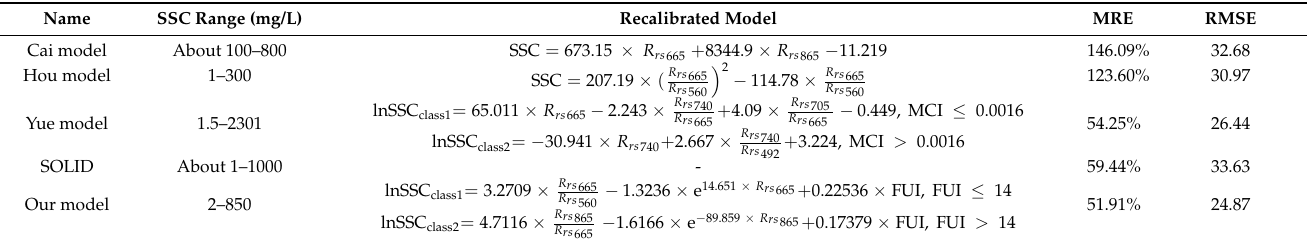
Table 3. Quantitative SSC retrieval models. The coefficients were adjusted in the study using match-ups of in situ and Sentinel-2